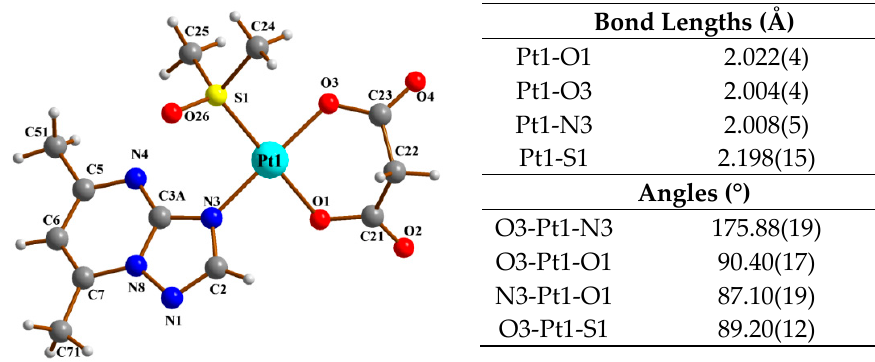
Figure 3. X-ray crystal structure of ( 5 ) [Pt(mal)(DMSO)(dmtp)] with selected bond lengths (Å) and angles (°).